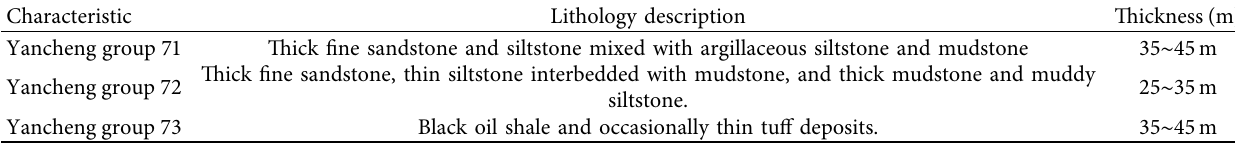
Table 1: Description of 7 segments of the Yancheng